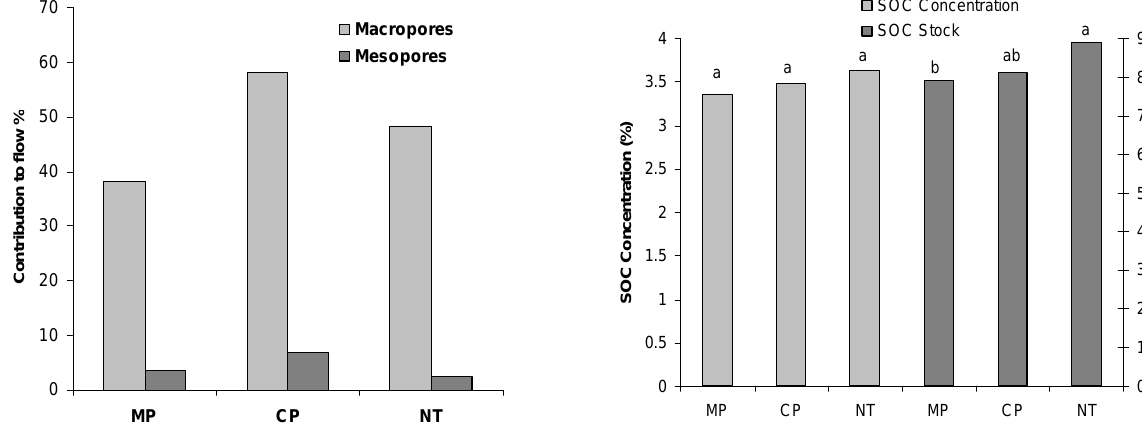
Figure 4. Comparison of pores’ contribution to flow (% of the to- tal flow) among different tillage treatments: moldboard plow (MP), chisel plow (CP), and no tillage (NT).